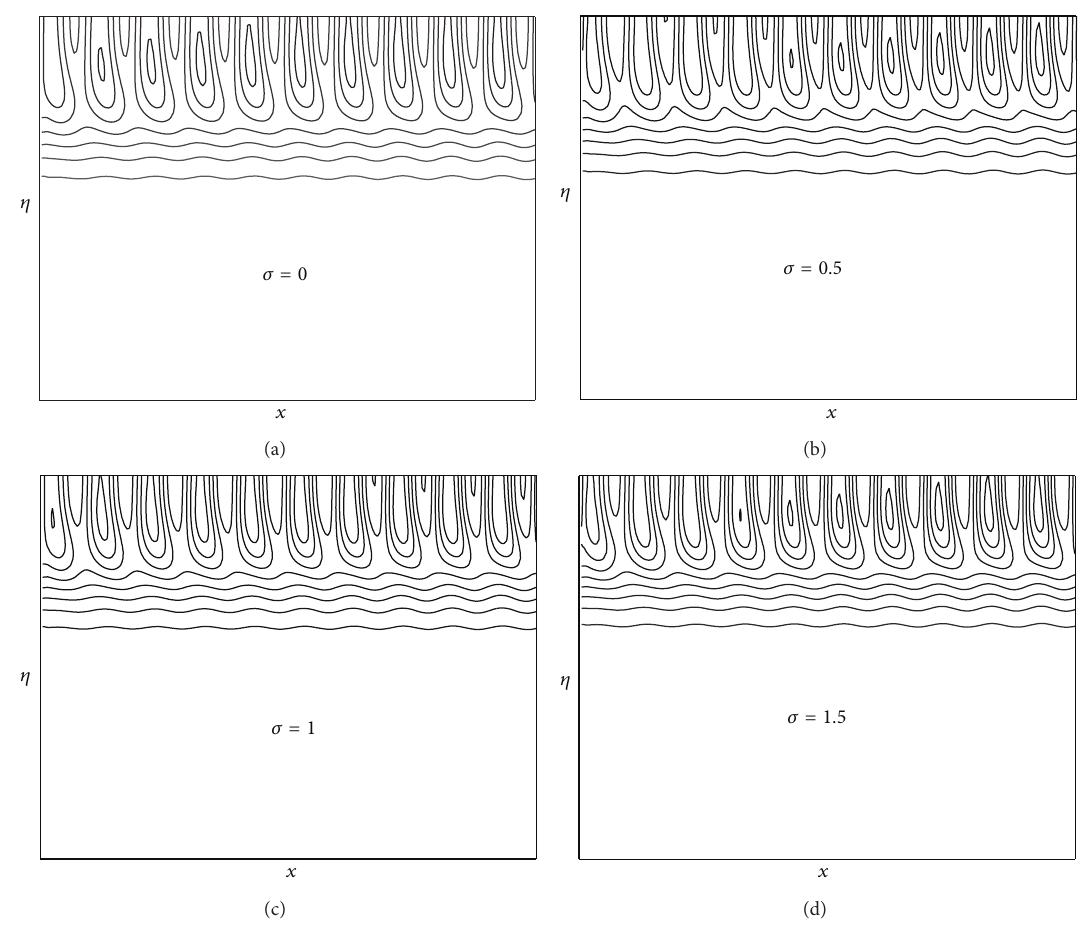
Figure 8: Le = 1 , Pr = 1 , 𝐴 = 0.1 , Nr = 0.1 , Nt = 0.1 , and Nb = 0.5